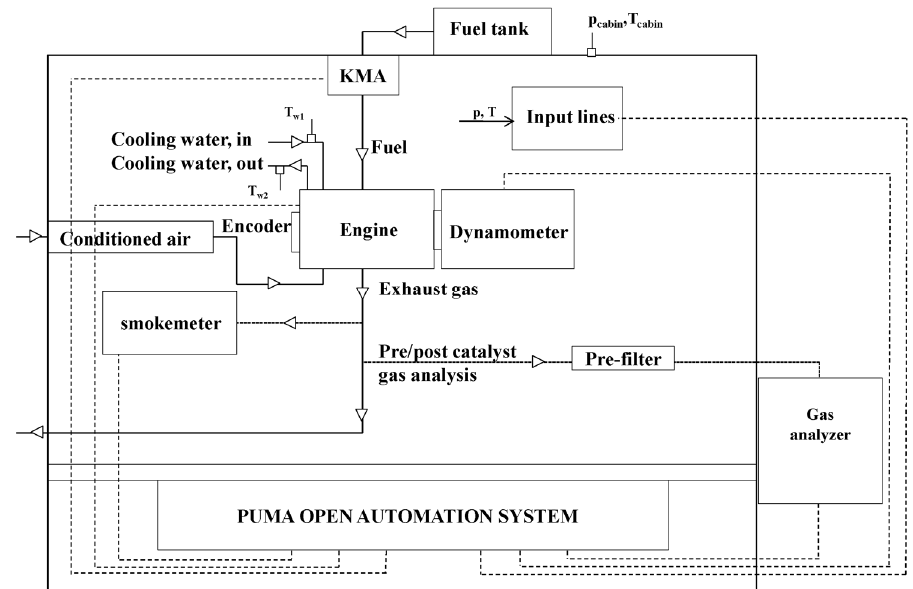
Figure 1. Schematics of the engine test bench.